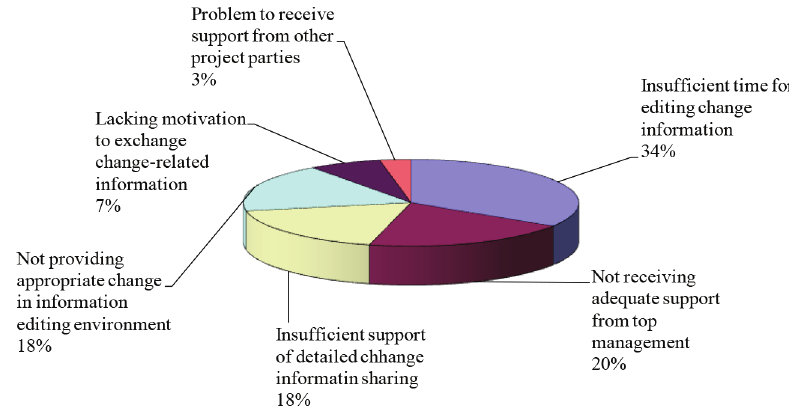
Fig. 7. Main difficulties of using the WPCM system in the case